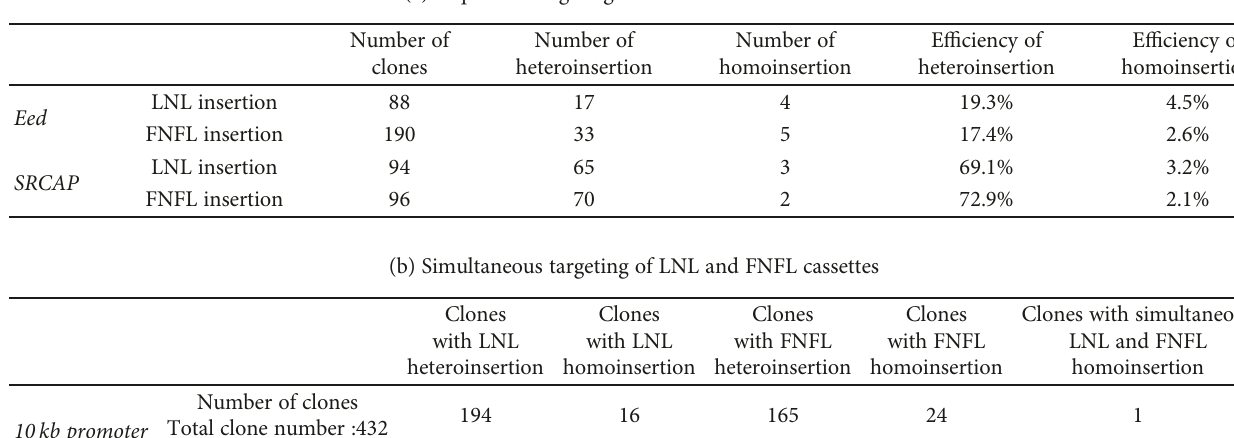
Table 1: Targeting e ffi ciency of LNL and FNFL cassettes.